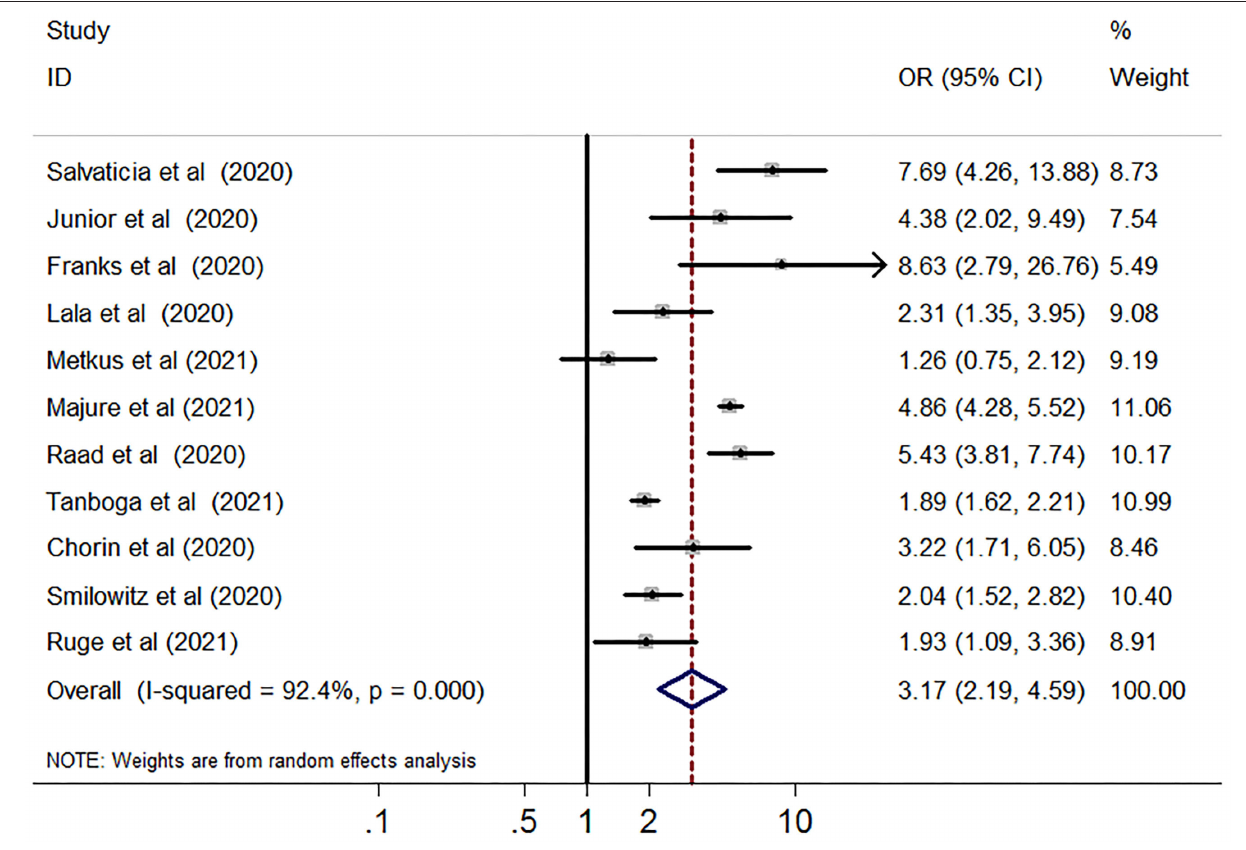
FIGURE 2 | Funnel plot of myocardial injury and risk of short-term all-cause mortality in patients with COVID-19. Meta-analysis of elevated vs. non-elevated cardiac troponin levels and risk of short-term all-cause mortality in patients with COVID-19. CI, confidence interval; OR, odds ratio.